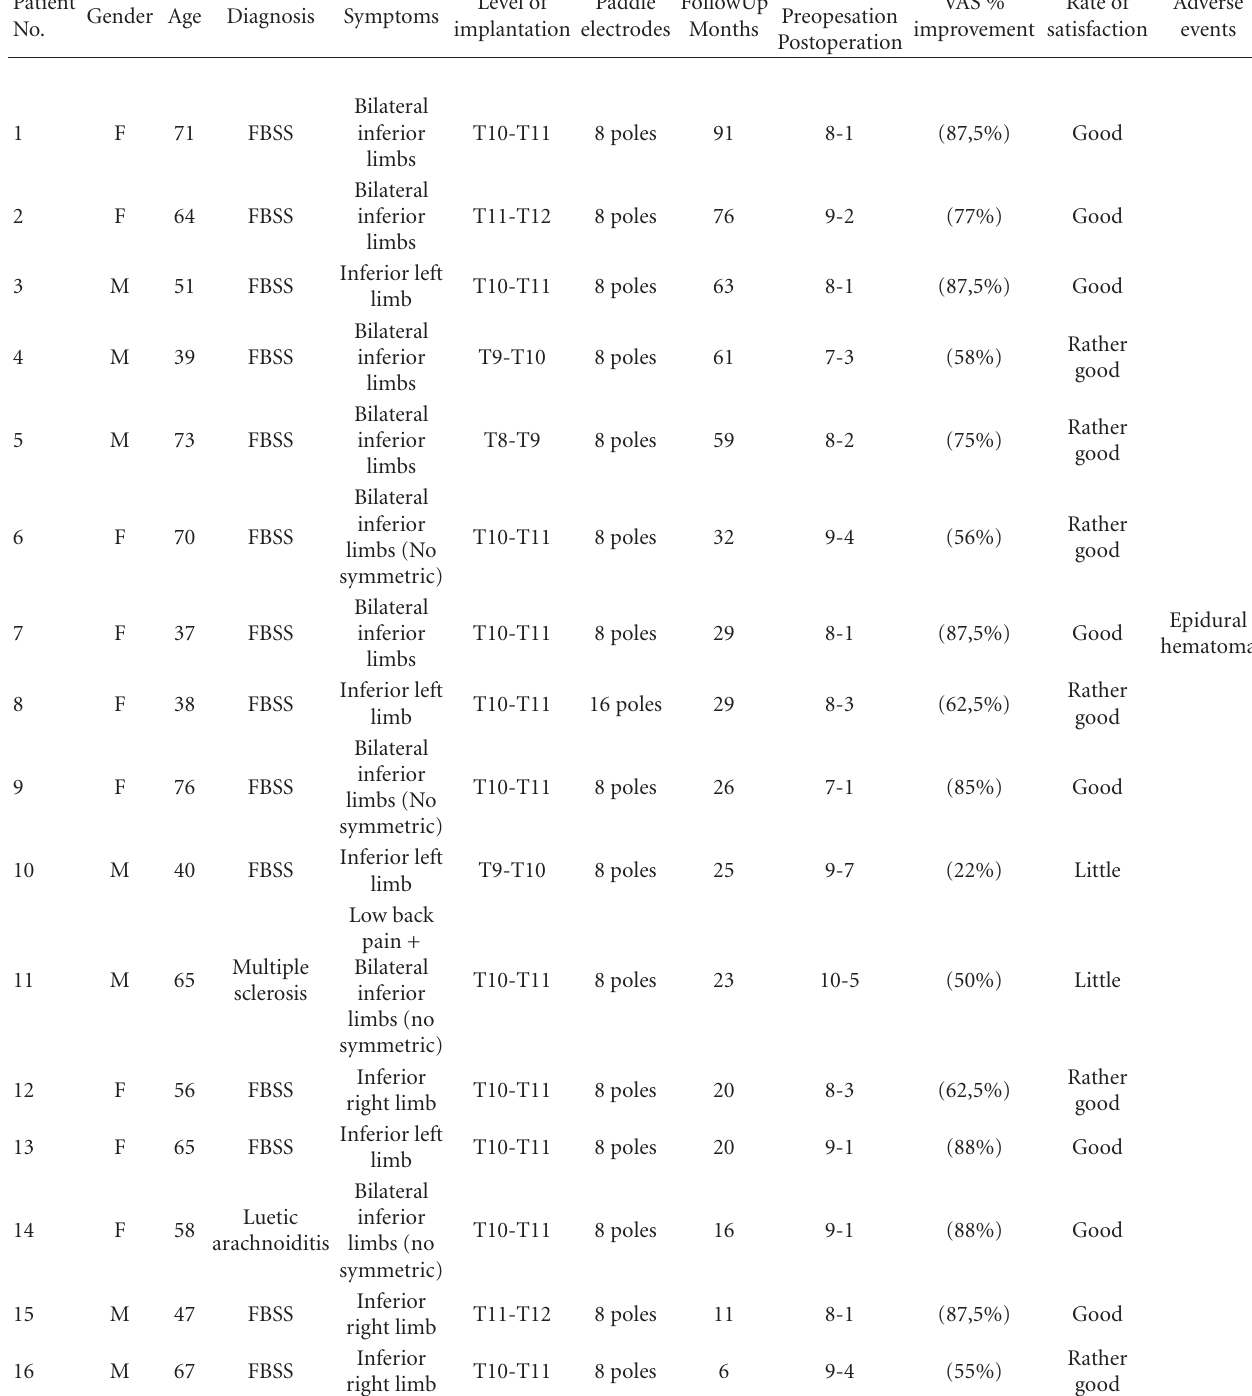
Table 1: Summary of our case series. VAS (Visual Analogue Scale), FBSS (Failed Back Surgery Syndrome).